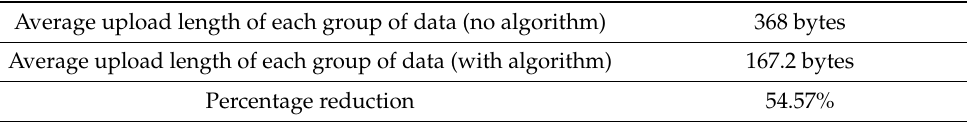
Figure 9. Reduce the length of uploaded data (using both methods). Table 2. Average length of data (using both methods).